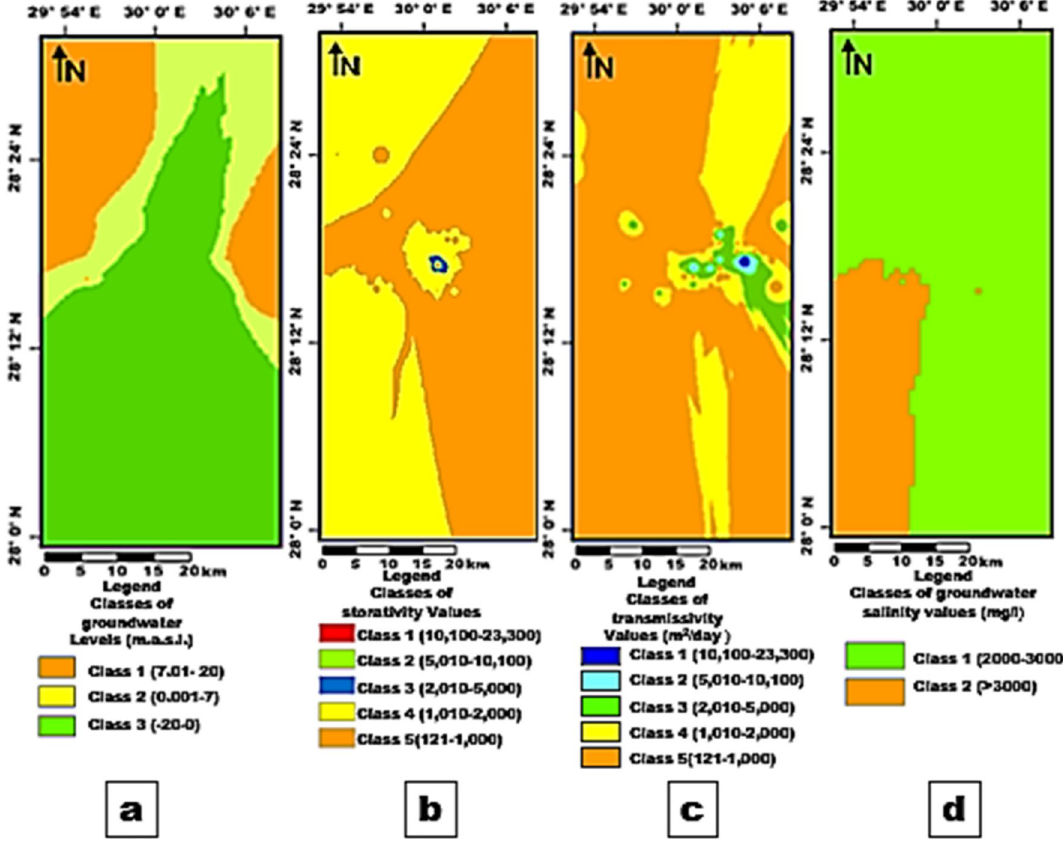
Fig. 18 Reclassified thematic maps: a groundwater level, b storativity, c transmissivity, and d groundwater